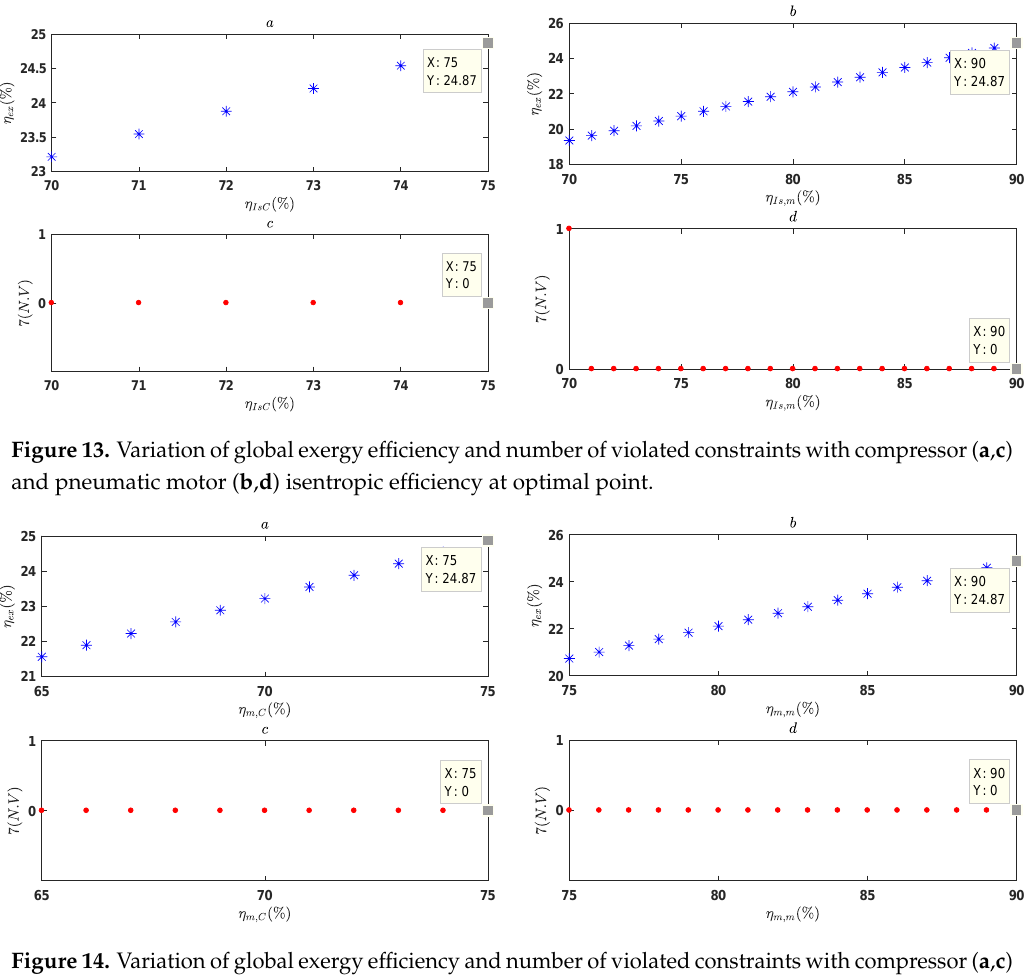
Figure 14. Variation of global exergy efficiency and number of violated constraints with compressor ( a , c ) and pneumatic motor ( b , d ) mechanical efficiency at optimal